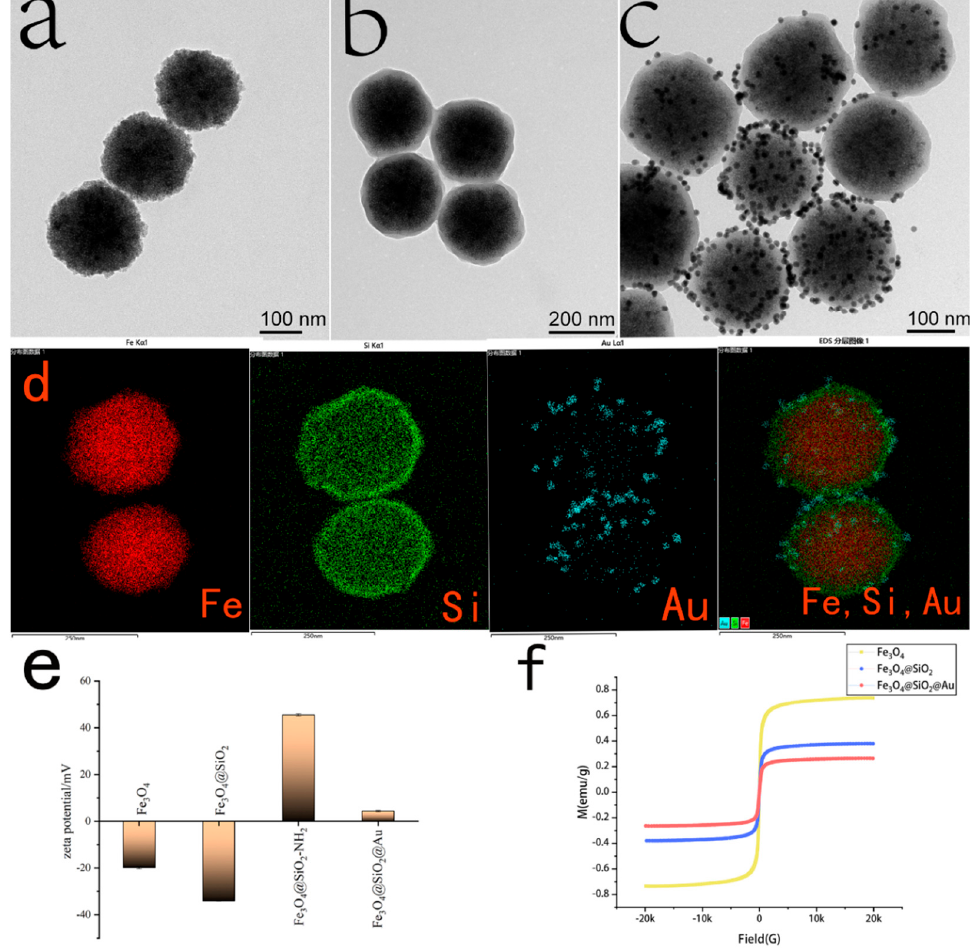
Figure 3. Characterization of nanoparticles: TEM images of ( a ) Fe3O4NPs, ( b ) Fe 3 O 4 @SiO 2 NPs and ( c ) Fe3O4@SiO2@AuNPs. ( d ) The elemental mapping images of Fe3O4@SiO2@Au MNPs based on Fe, Si and Au elements. ( e ) The zeta potential of Fe 3 O 4 NPs, Fe 3 O 4 @SiO 2 NPs, Fe 3 O 4 @SiO 2 − NH2 and Fe 3 O 4 @SiO 2 @AuNPs. ( f ) The hysteresis loop of Fe 3 O 4 NPs, Fe 3 O 4 @SiO 2 NPs and Fe 3 O 4 @SiO 2 @AuNPs.